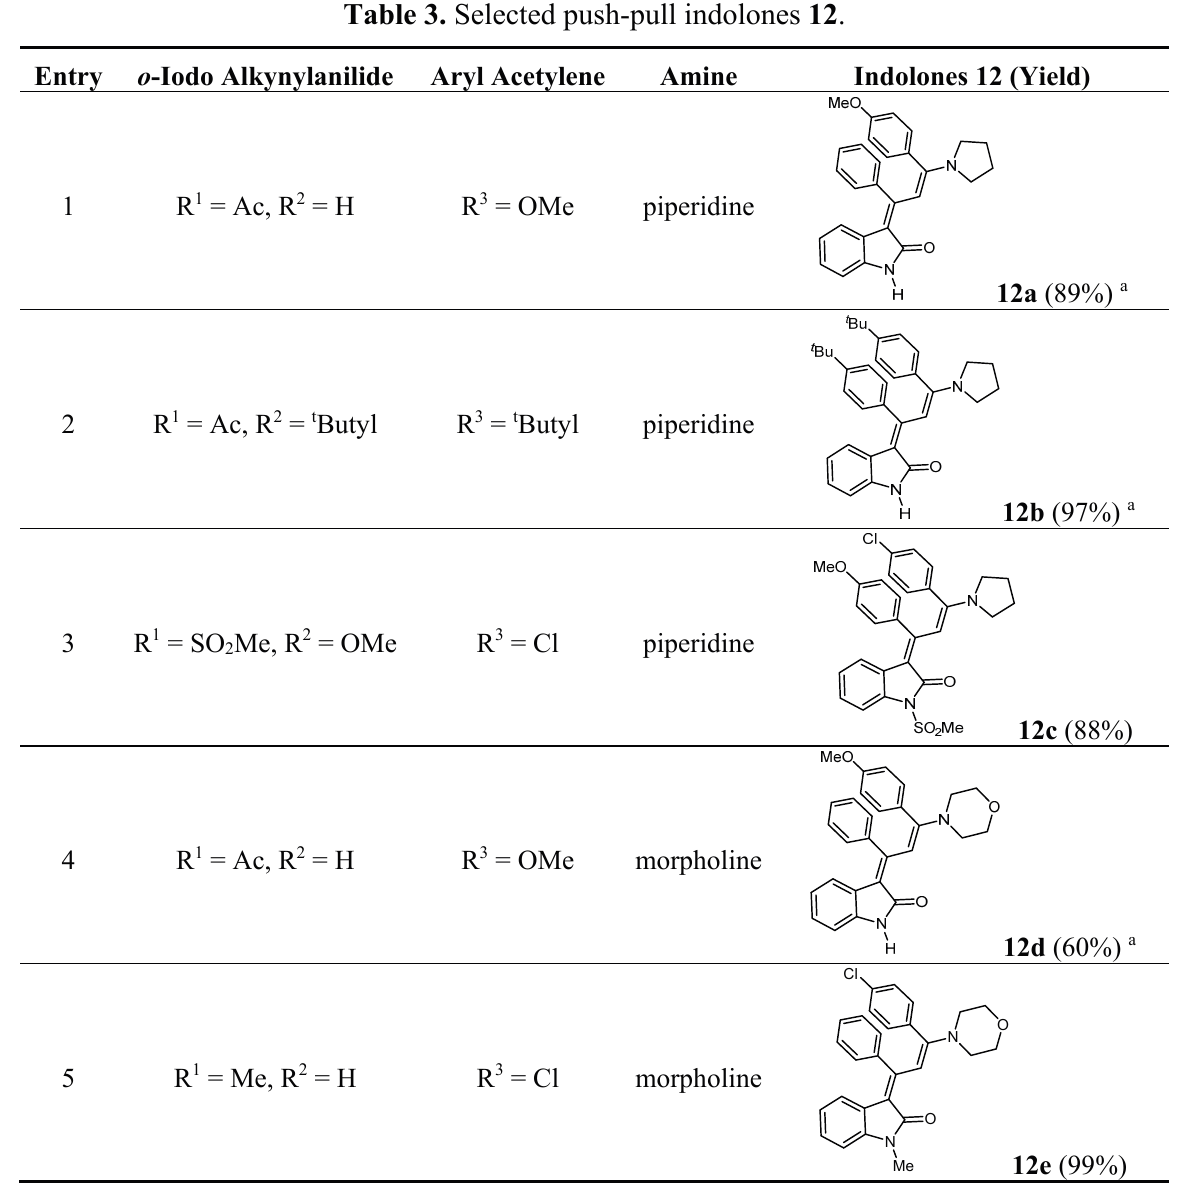
Table 3. Selected push-pull indolones 12